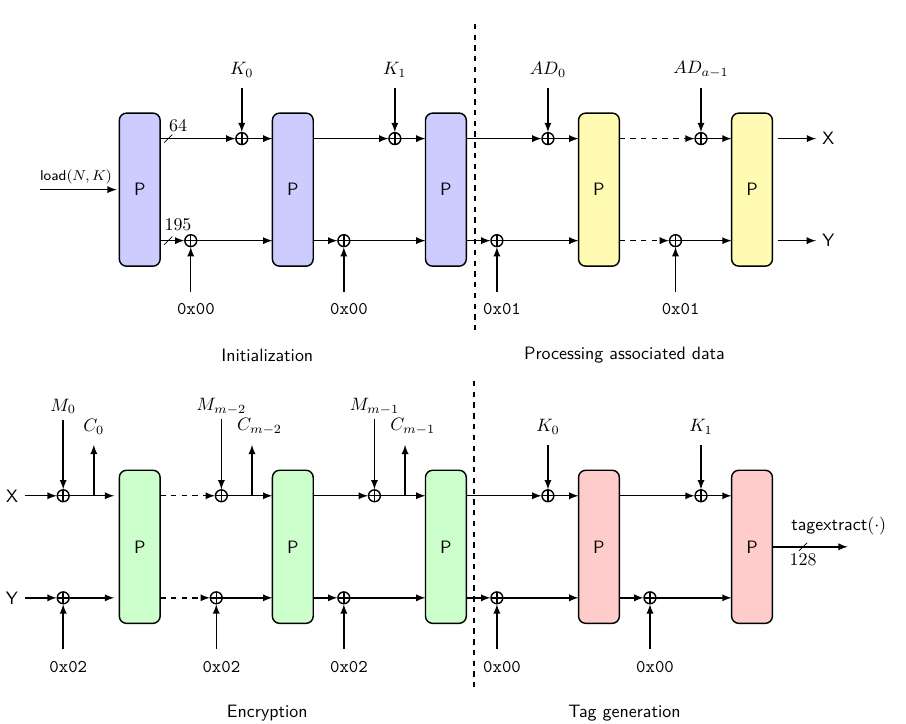
Figure 6: The WAGE - AE -128 encryption algorithm where P = WAGE permutation where WAGE ( · ) denotes the WAGE